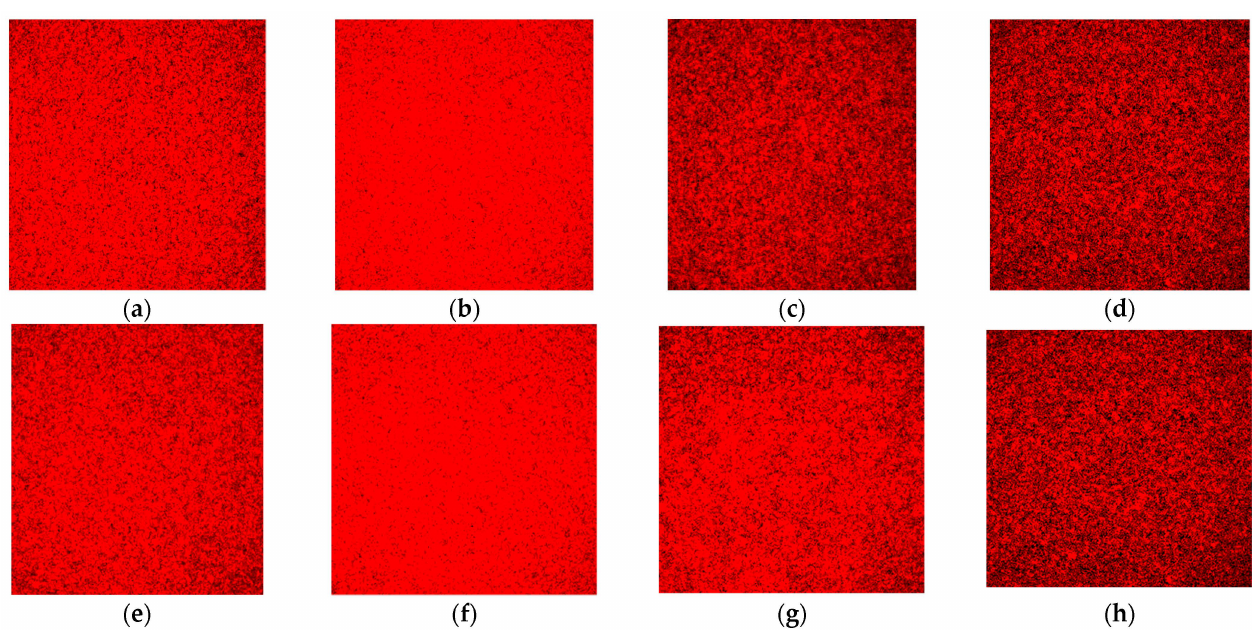
Figure 7. Representative CLSM images of protein content in the biofilm stained with the SyPRO biofilm matrix stain: ( a ) E. faecalis as a monospecies culture under aerobic conditions; ( b ) E. faecalis as co-culture under aerobic conditions; ( c ) E. faecalis as a monospecies culture under anaerobic conditions; ( d ) E. faecalis as co-culture under anaerobic conditions; ( e ) P. gingivalis as a monospecies culture under aerobic conditions; ( f ) P. gingivalis as co-culture under aerobic conditions; ( g ) P. gingivalis as a monospecies culture under anaerobic conditions; and ( h ) P. gingivalis as co-culture under anaerobic conditions. Note: Protein contents are stained red. Images with a greater degree of redness denote a greater amount of protein contents, as seen in ( b , f